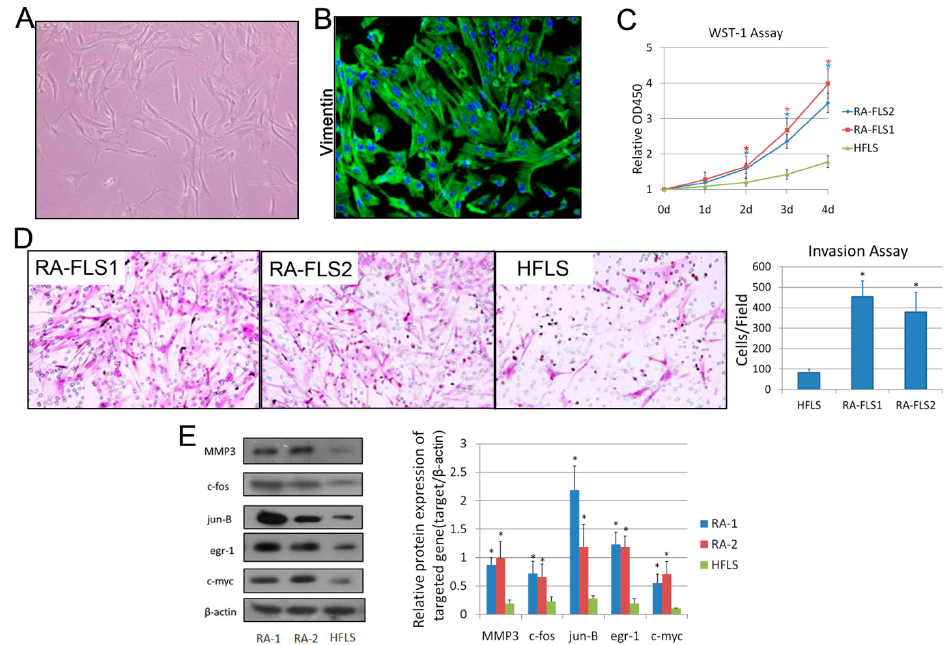
Figure 1. Isolation and identification of fibroblast-like synoviocytes (FLS) from synovial tissues of rheumatoid arthritis (RA) patients. ( A ) Microscope photo of FLSs isolated from human synovial tissue at passage 3 (100 × ). ( B ) Immunofluorescence analysis of the isolated FLSs using anti-Vimentin antibody and DAPI. ( C ) WST-1 assay, measuring the activity of mitochondrial dehydrogenases, was performed following the manufacturer’s instructions at 0-, 1-, 2-, 3- and 4-day time points. Error bars represent standard deviation (SD) of the mean. * p < 0.05 versus the normal human FLS line (HFLS). ( D ) Cell invasion was determined using a Transwell assay as described in the Materials and Methods Section. Microscopic image of migrated cells is shown. Original magnification: 200 × . Diagrams of migrating cells from the groups are shown, which were obtained from more than three independent experiments. * p < 0.05 versus HFLS. ( E ) Total cell lysates of RA–FLS1 and 2, and HFLS, were examined by Western blotting. Diagrams of the relative gray value are shown, which were obtained from more than three independent experiments. * p < 0.05 versus